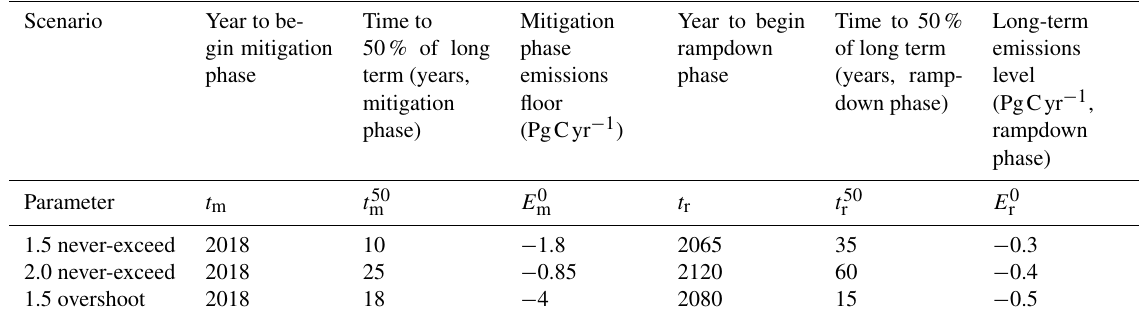
Table C1. Parameters for the three scenarios described in this study, using the functional form established in Sanderson et al. (2016), t m is the year that emissions depart from the RCP8.5 scenario and begin the mitigation phase, t 50 m describes the rate of decarbonization in the mitigation phase, defined as the number of years after the mitigation phase start time that the emissions are equidistant between 2018 emissions and the emissions floor level, E 0 m is the asymptotic level to which carbon emissions decay in the mitigation phase, t r is the year in which the mitigation phase ends and the rampdown phase begins, t 50 r is the number of years after the rampdown start time that the emissions are equidistant between emissions in year E 0 r and the long-term emissions floor level and e r is the asymptotic level to which carbon emissions f decay in the rampdown